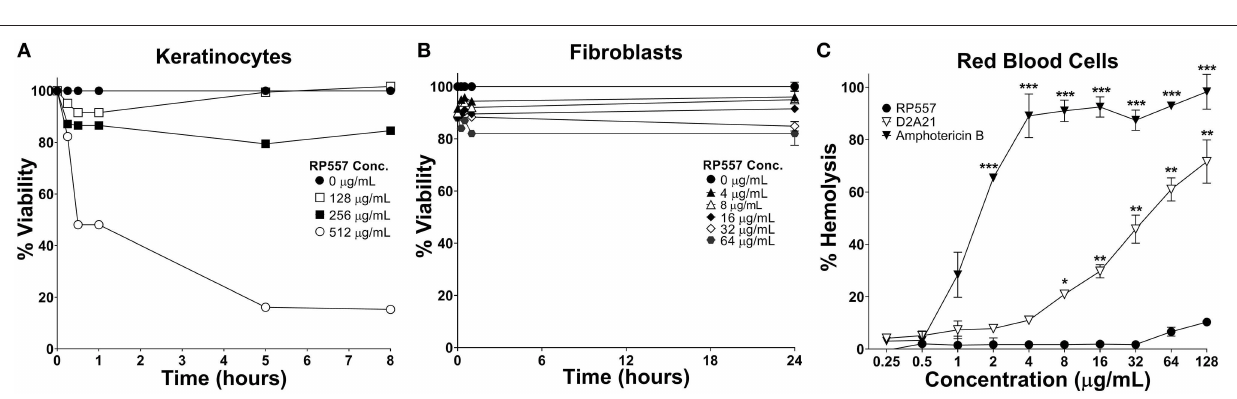
FIGURE 4 | RP557 exhibits minimal cytotoxicity. Keratinocyte and fibroblast cytotoxicity was non-invasively assayed using bioluminescent strains of human HaCaT keratinocytes (A) and murine L929 fibroblast cells (B) and viability assayed using an IVIS Lumina imaging system. Hemolysis toward human RBCs is shown in (C) . Data represents the mean ± SE. Bioluminescent experiments were performed in triplicate from two independent experiments. The red blood cell viability assay involved two replicates; statistically significant in comparison to RP557 (* P < 0.05; ** P < 0.01, *** P < 0.001), using one-way ANOVA followed by Tukey